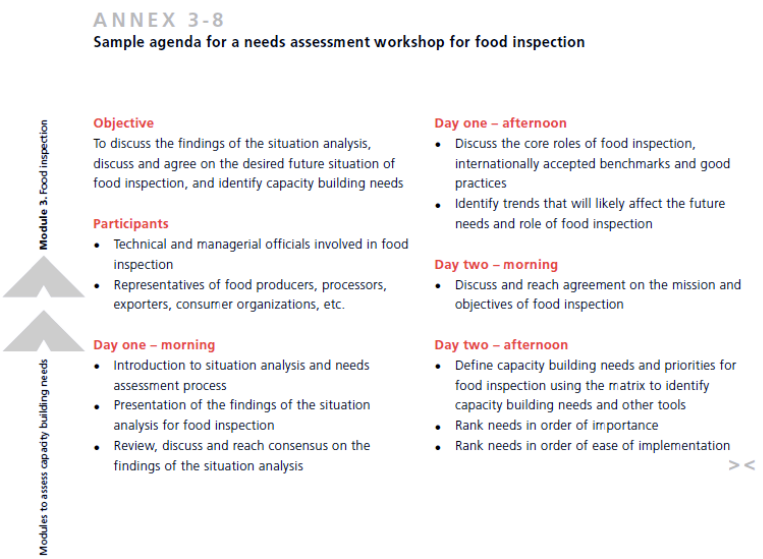
Figure A1. Agenda for discussion with national government